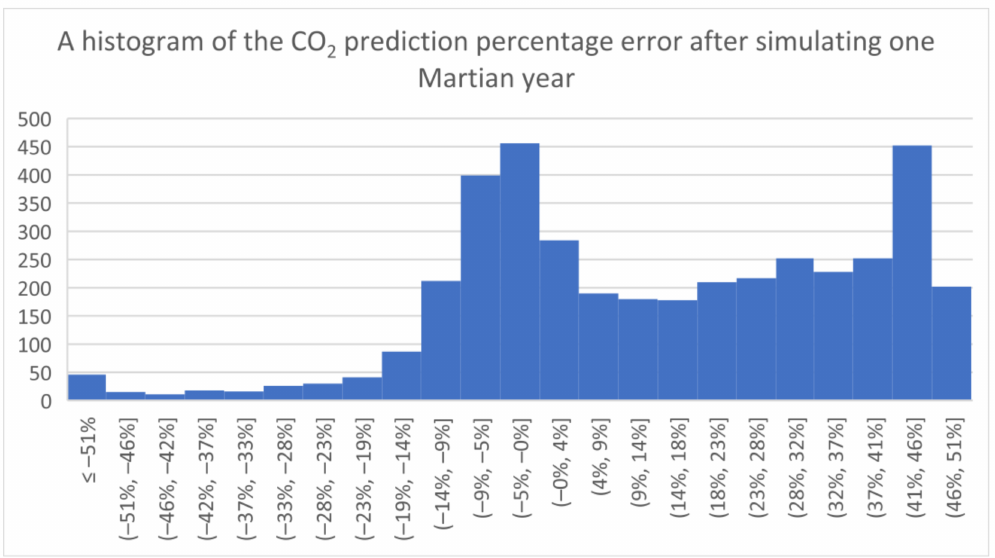
Figure 5. A histogram of the CO 2 prediction percentage error after simulating one Martian